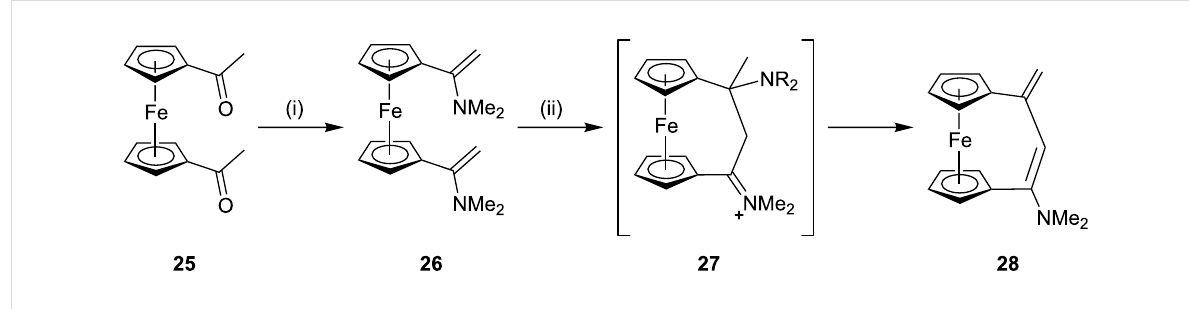
Scheme 1: Synthesis of [3]ferrocenophanes through Mannich reaction. Reagents and conditions: (i) excess HNMe 2 ; (ii) TiCl 4 , C 5 H 12 , − 78 °C, 20 min,